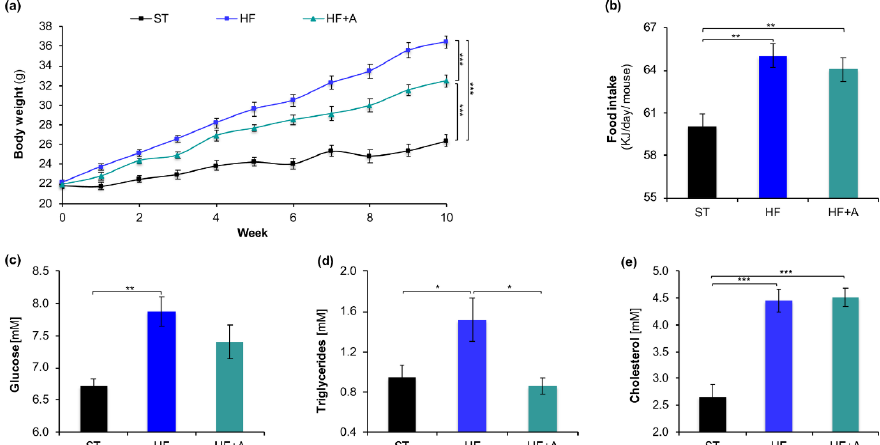
Figure 5. Agavins supplementation reduced body weight gain, food intake, glucose and cholesterol levels in mice fed high-fat diet. ( a ) Body weight evolution; ( b ) Food intake; ( c ) Glucose; ( d ) Triglycerides; ( e ) Cholesterol levels in blood. Data are shown as average SEM ( n = 7/group). Data were analyzed using one-way ANOVA, followed by Tukey multiple comparison test. Significant difference is indicated by * p < 0.05, ** p < 0.01, *** p < 0.001. HF (mice fed with a high-fat diet); HF+A